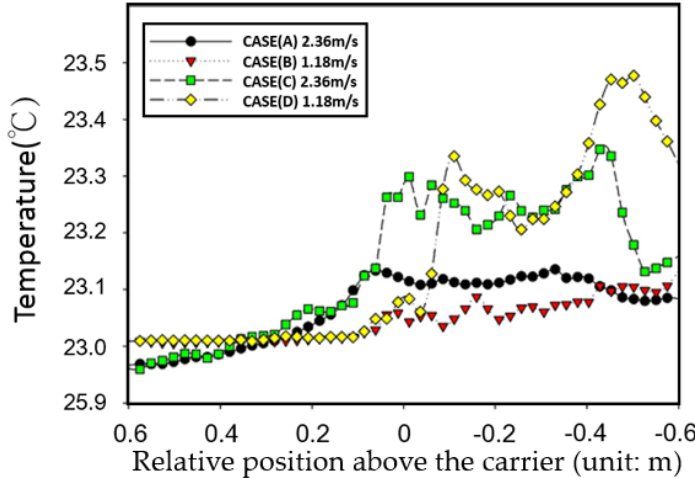
Figure 7. Numerical average temperature distributions along the moving path of a periodic moving carrier.